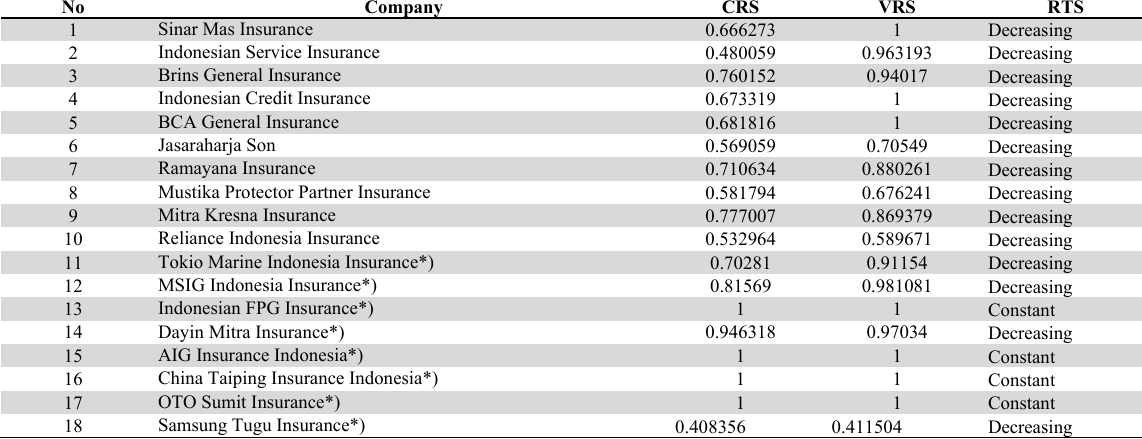
General Insurance Efficiency Level in 2018